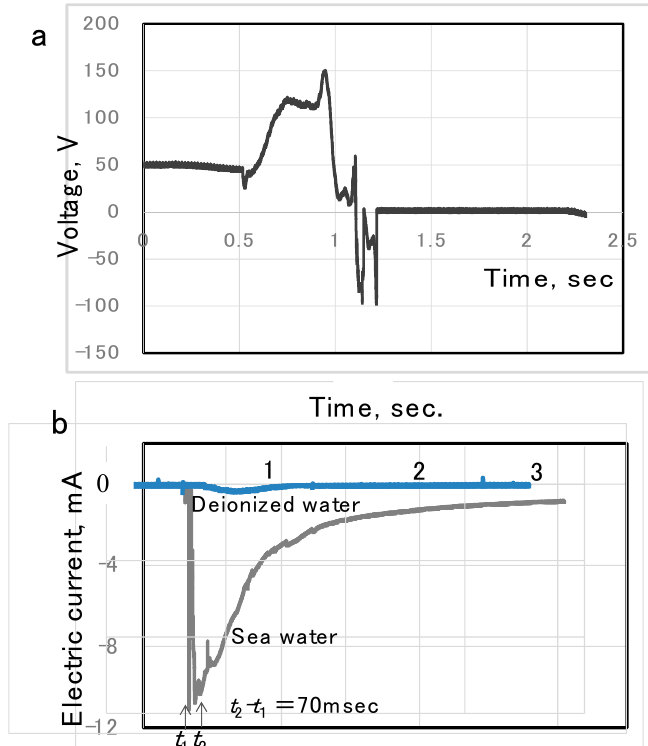
Figure 5. Results of the laboratory experiments of electrical response of splashed droplets when a steel weight was dropped on seawater bubbled with methane: ( a ) Electric potential of seawater, and ( b ) electric currents of de-ionized water (blue) and seawater (gray). Note that positive current is displayed on the negative side.